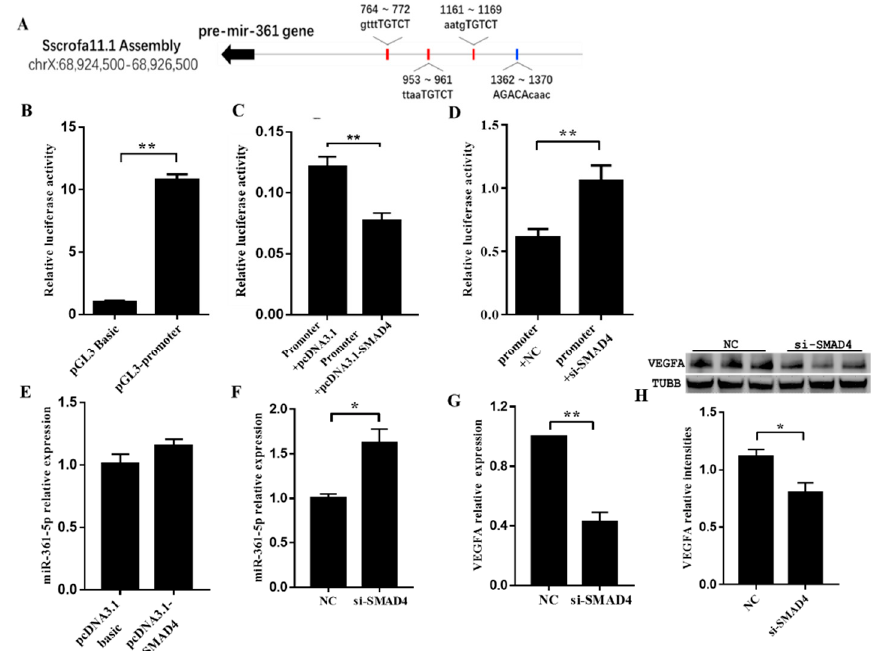
Figure 5. Transcription factor SMAD4 was involved in miR-361-5p mediated VEGFA expression. ( A ): Schematic diagram showing the genome location of the miR-361-5p coding gene and potential SMAD4 binding sites. ( B ): The promoter activity of MIR361 upstream region confirmed by the dual-luciferase reporter assay; ( C , D ): Overexpression and knockdown of SMAD4 weaken and enhanced MIR361 promoter activity, respectively; ( E ): The expression of miR-361-5p was not a ff ected after SMAD4 overexpression; ( F ): The expression of miR-361-5p was up-regulated after SMAD4 knockdown; ( G , H ): The expression of VEGFA mRNA and protein levels were down-regulated after SMAD4 knockdown. n = 3 cell culture wells per group. Data are expressed as the mean ± SEM. * p < 0.05, ** p < 0.01.